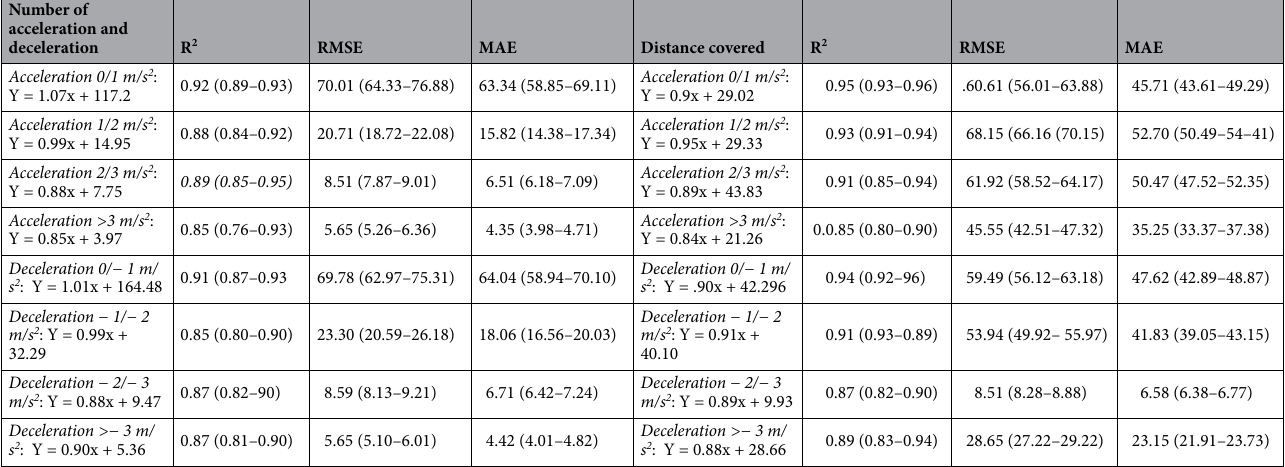
Table 5. The regression equations and cross-validation in distance covered and number of accelerations and decelerations in different sections. R 2 R-square, RMSE root mean squared error, MAE mean absolute error.